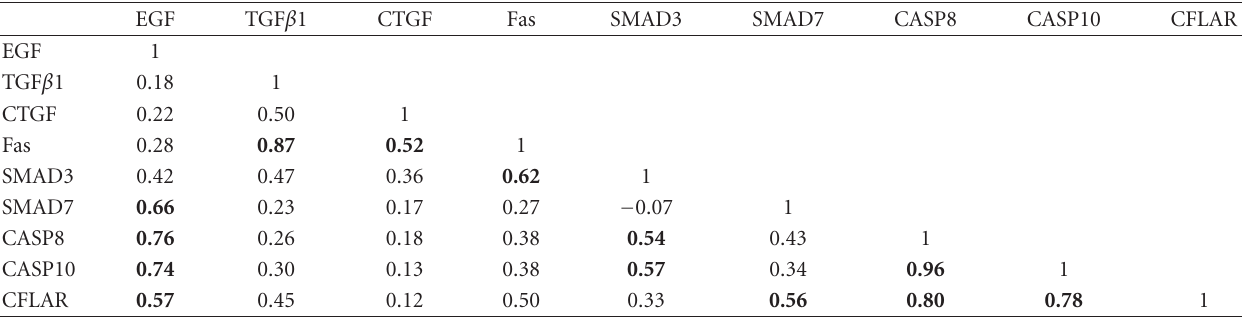
Table 3: Coexpression matrix for nine Fas-related genes assayed by RT-PCR in 34 SW1353 chondrosarcoma cell cultures treated topically with rhEGF, alone or following EGF/TGF β receptor inhibition. Correlation coe ffi cients in bold are significant at P ≤ 1 . 1 E − 03 (Bonferroni’s adjustment).